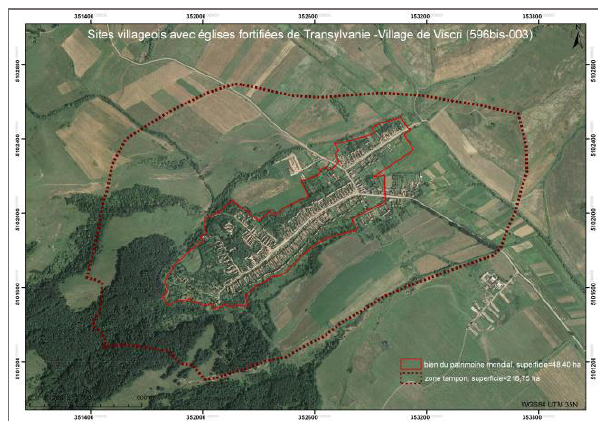
Figure 13. Unesco protected area and buffer zone- Viscri case study (Unesco).